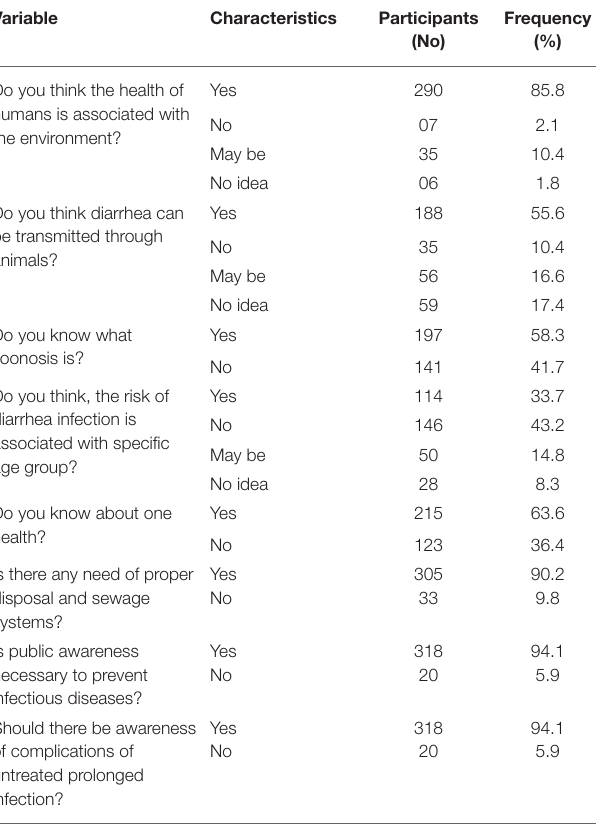
TABLE 4 | Practices toward diarrhea of participants in the study. Variable